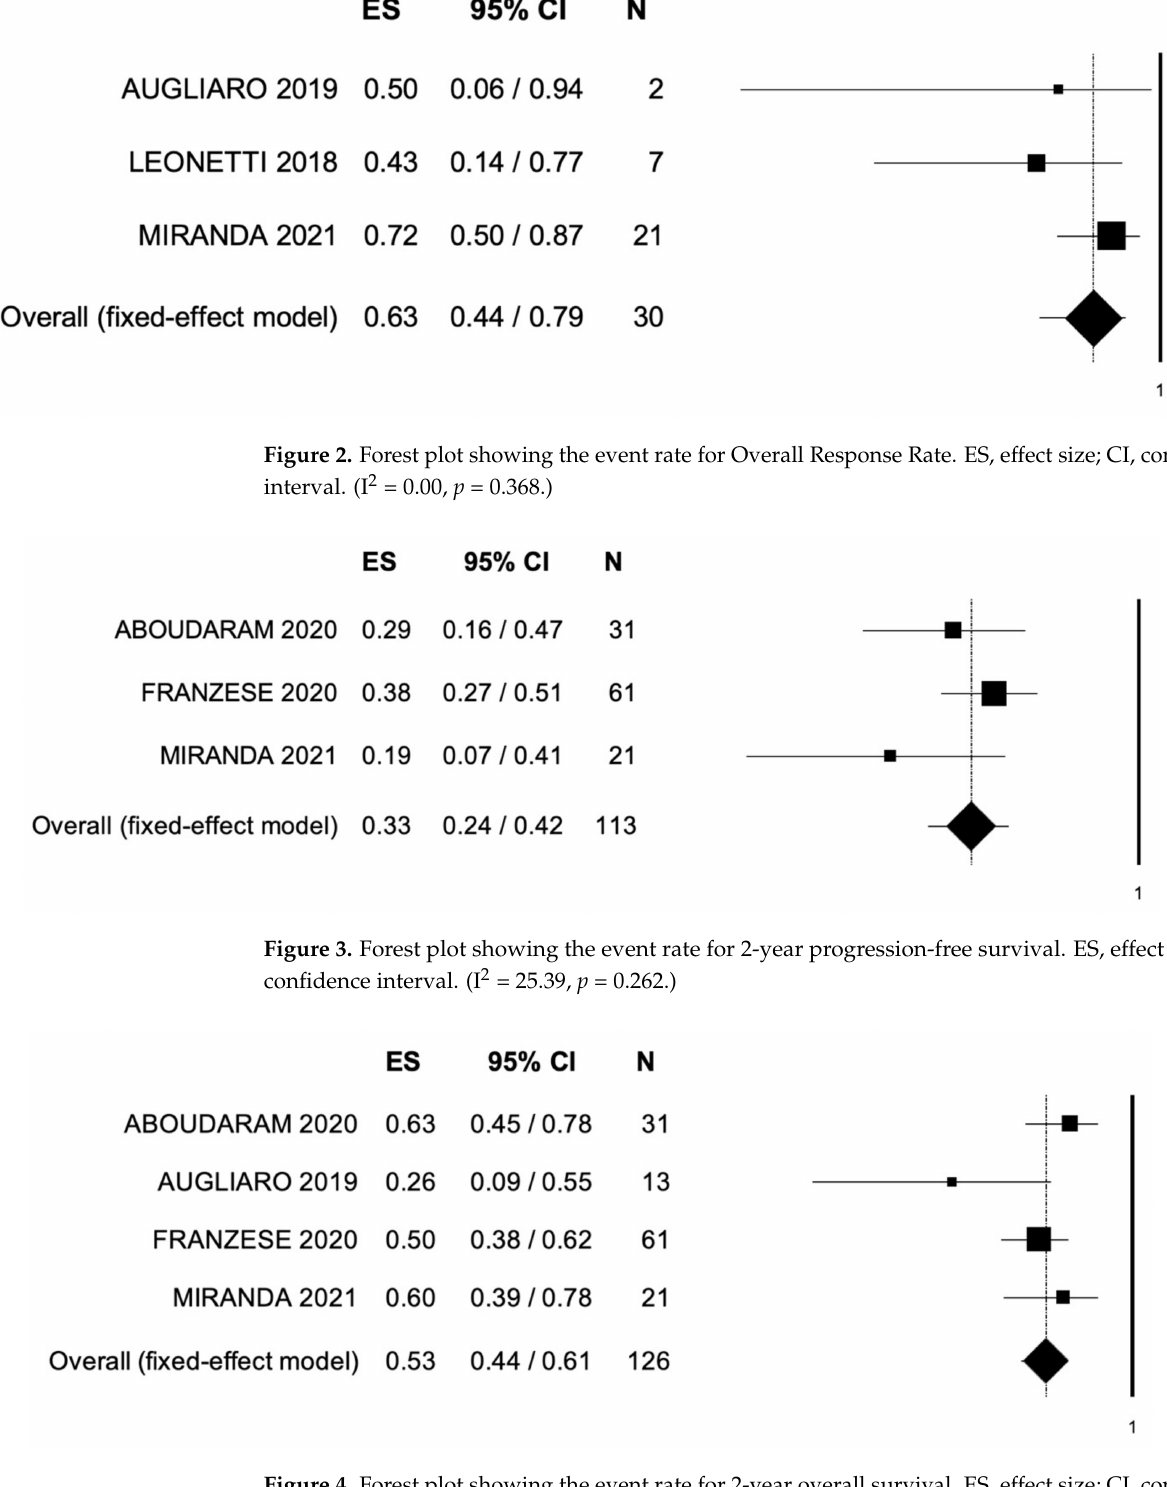
Figure 4. Forest plot showing the event rate for 2-year overall survival. ES, effect size; CI, confidence interval. (I 2 = 42.91, p =